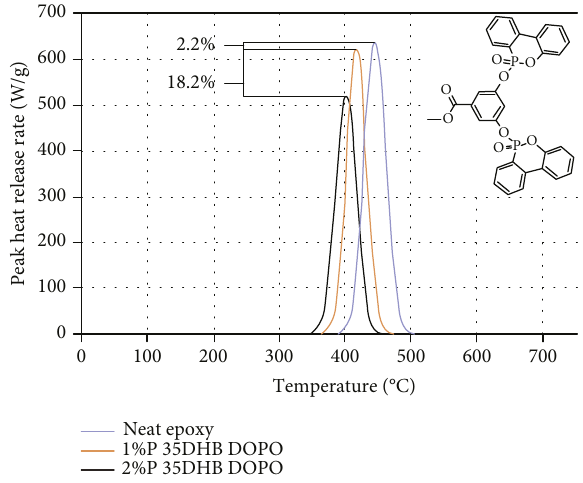
Figure 5: Peak heat release rates for blends of methyl 3,5-di(diethylphosphato)benzoate in DGEBA epoxy.